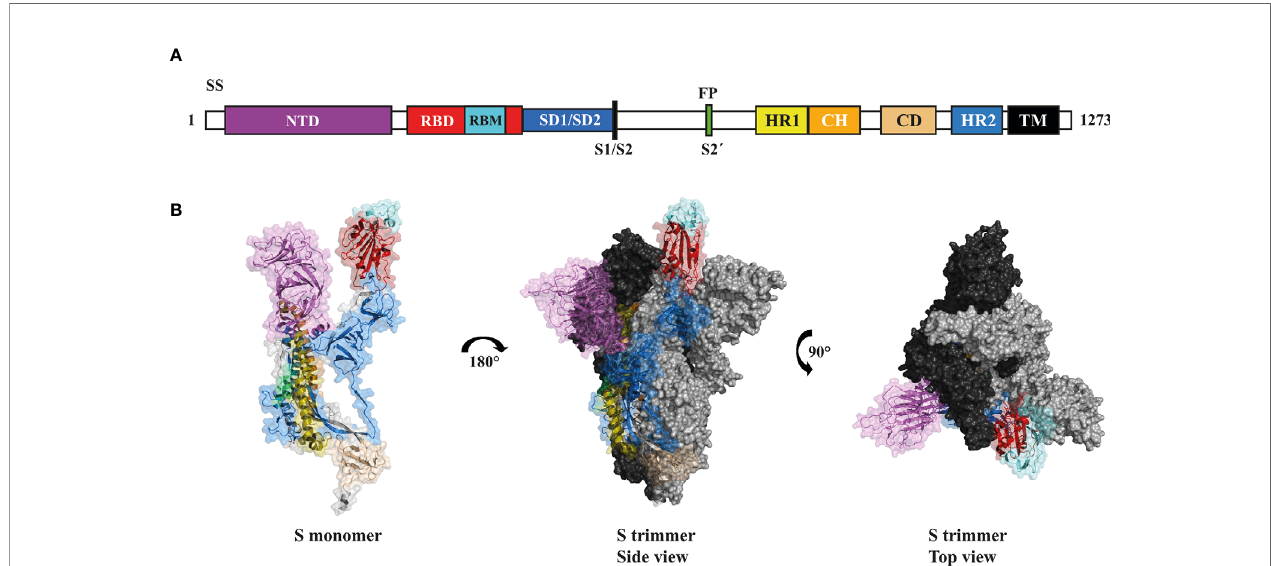
FIGURE 2 | Structural characteristics of the trimeric S glycoprotein of SARS-CoV-2. (A) Schematic representation of the composition and arrangement of domains present in the SARS-CoV-2 S glycoprotein. Signal sequence (SS), N-terminal domain (NTD), receptor-binding domain (RBD), subdomain 1 and 2 (SD1/2), furin cleavage site (S1/S2, arrow), protease cleavage site 2 ′ (S2 ′ , arrow), fusion peptide (FP), heptad repeat 1 (HR1), central helix (CH), connector domain (CD), heptad repeat 2 (HR2), transmembrane domain (TM), cytoplasmic tail (CT). (B) Side view of the SARS-CoV-2 S glycoprotein monomer (PDB: 7DK3) in open state using the same color representation as in panel A (left). Side (middle) and top (right) views of the oligomeric conformation. The second (grey) and third (black) sub-units of the trimer are shown in the closed